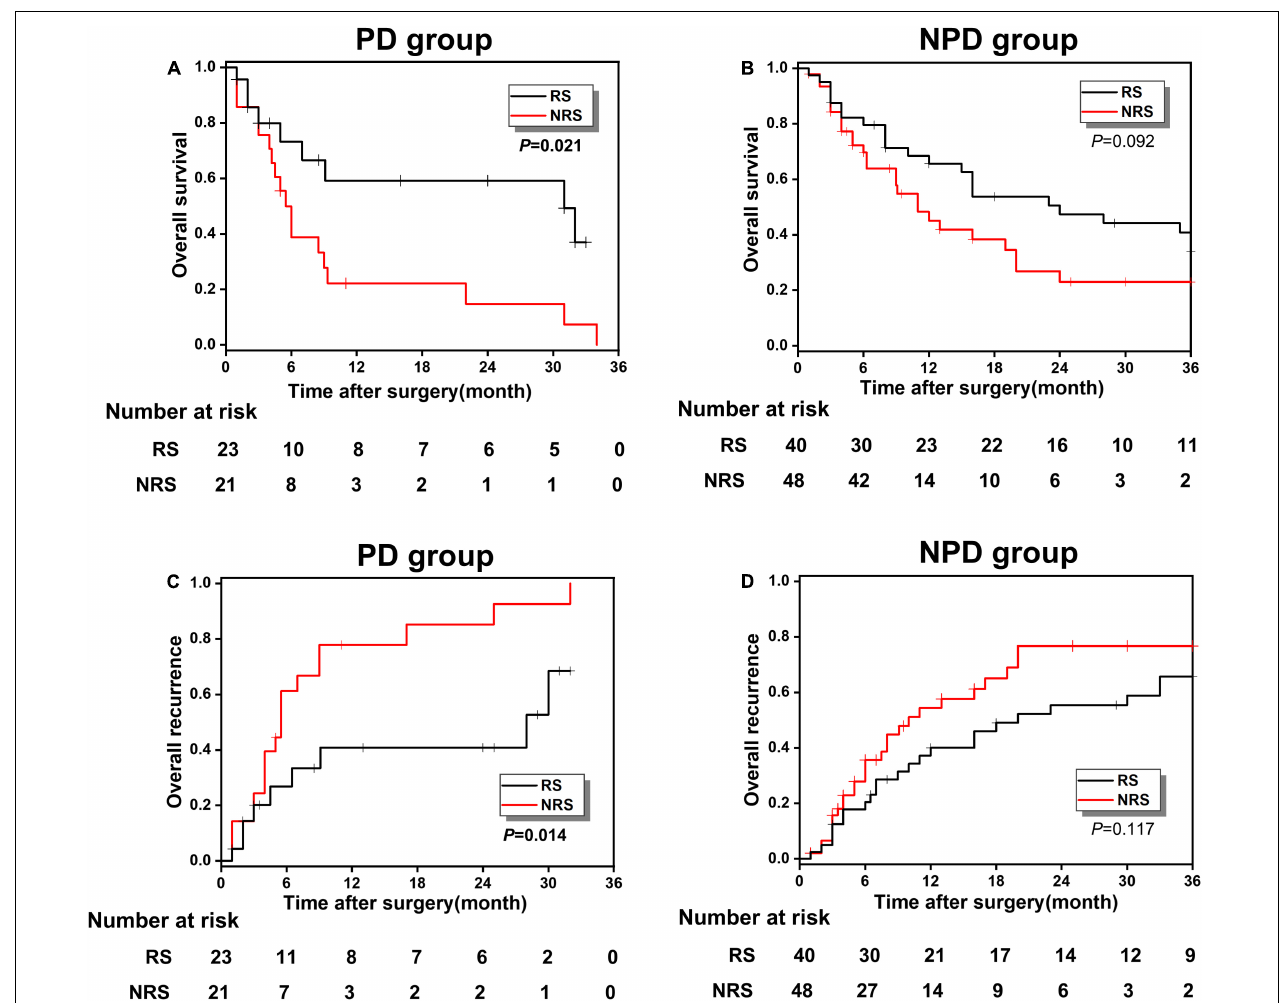
FIGURE 6 | (A,B) The OS comparison between the RS and NRS subgroups in PD and NPD groups; (C,D) the overall recurrence comparison between the RS and NRS subgroups in PD and NPD